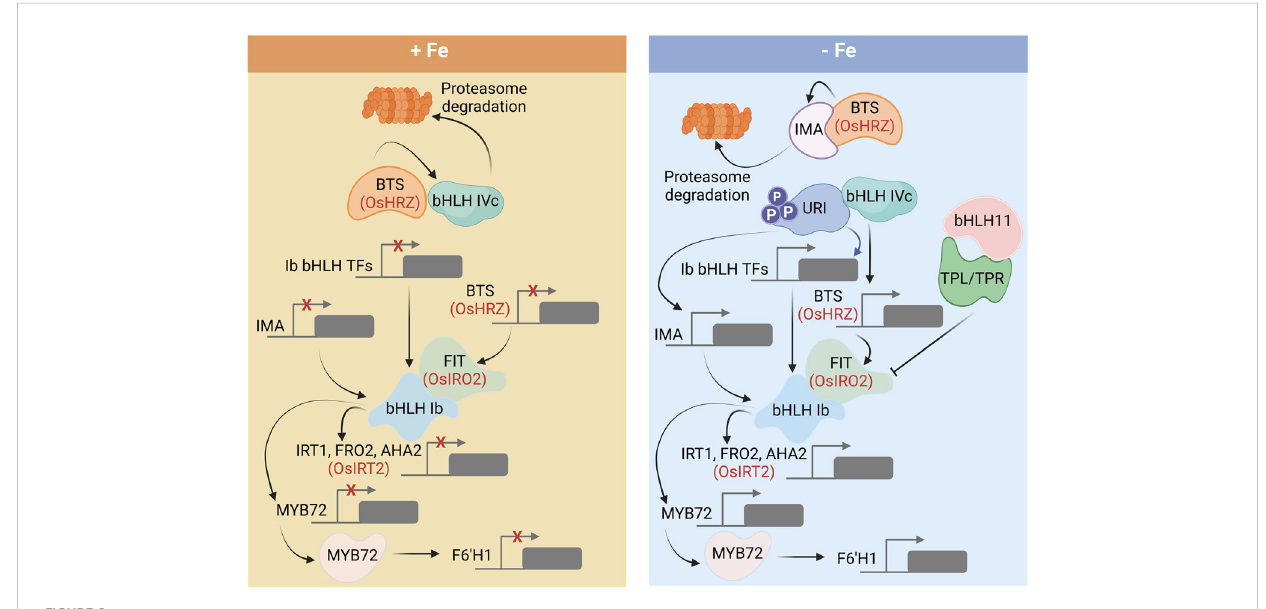
FIGURE 2 Regulatory cascade governing the expression of genes involved in Fe uptake and homeostasis in Arabidopsis and rice. Under Fe-suf fi cient conditions, BTS degrades clade IVc bHLH proteins and inhibits downstream signaling. When cytosolic Fe becomes limited, URI (clade IVb) is phosphorylated and promotes the transcription of clade Ib bHLH proteins, which forms heterodimers with FIT (bHLH29) to induce the root Fe uptake. bHLH11 recruits TOPLESS/TOPLESS-RELATED (TPL/TPRs) co-repressors and counteracts the expression of clade Ib bHLH transcription factors. Detailed explanations regarding the various components are given in the text. Rice homologs are denoted in red letters. Figure was created with